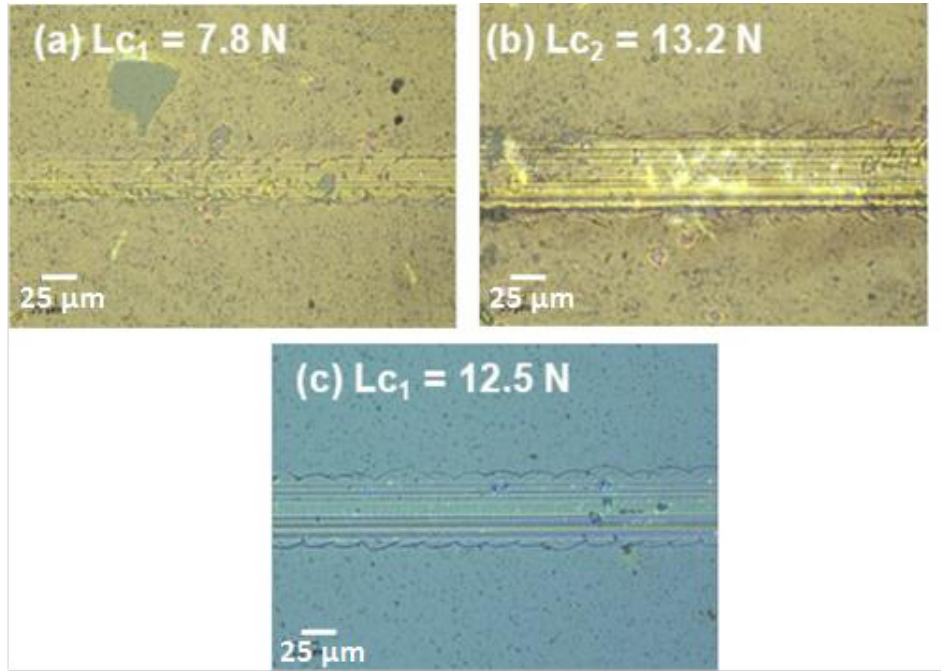
Figure 9. ( a , b ) Lc 1 and Lc 2 location along with the scratch for the coating deposited at 300 ◦ C; ( c ) The Lc 1 location along with the scratch for the coating deposited at 500 ◦